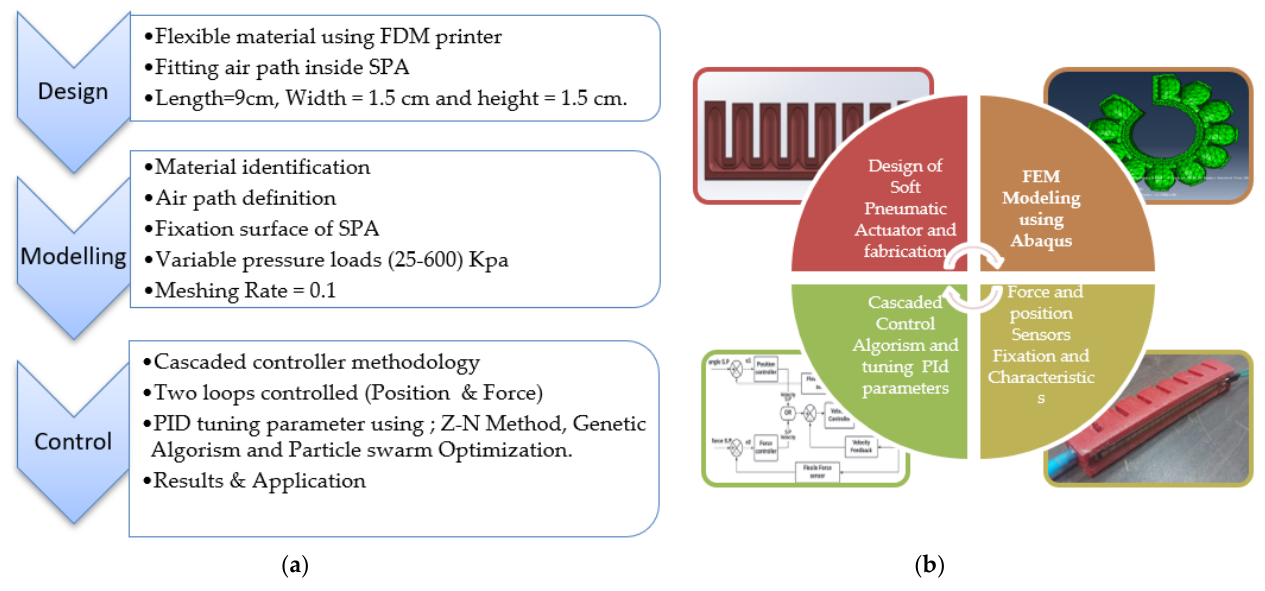
Figure 1. ( a ) Framework to illustrate workflow; ( b ) Graphical representation to work sequence.